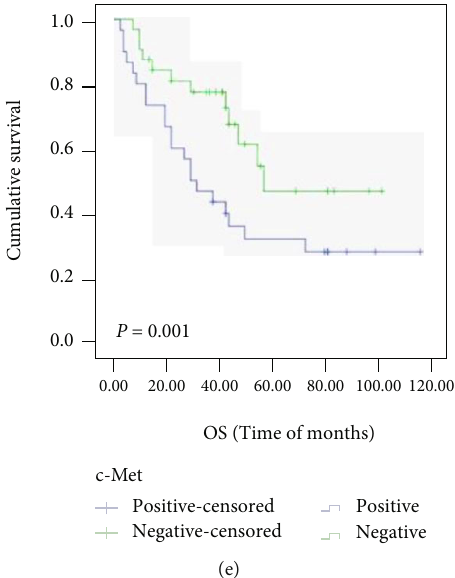
Figure 5: OS and PFS of ESCC patients after chemotherapy were analyzed by the Kaplan – Meier method. Notes: (a) OS according to postoperative chemoradiotherapy ( P = 0 : 001 ); (b) PFS according to postoperative chemoradiotherapy ( P = 0 : 01 ); (c) OS according to MACC1 expression ( P = 0 : 03 ); (d) OS according to c-Met expression ( P = 0 : 003 ); (e) PFS according to c-Met expression ( P = 0 : 03 ).